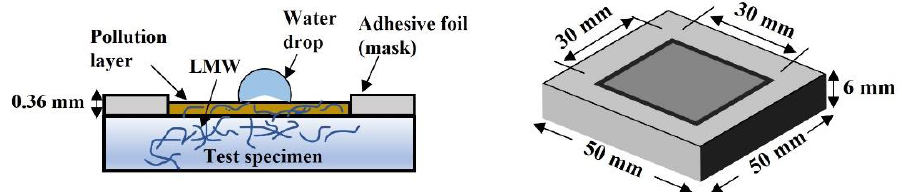
Figure 10. Specimen with adhesive foil (masking) and pollution layer during hydrophobicity transfer